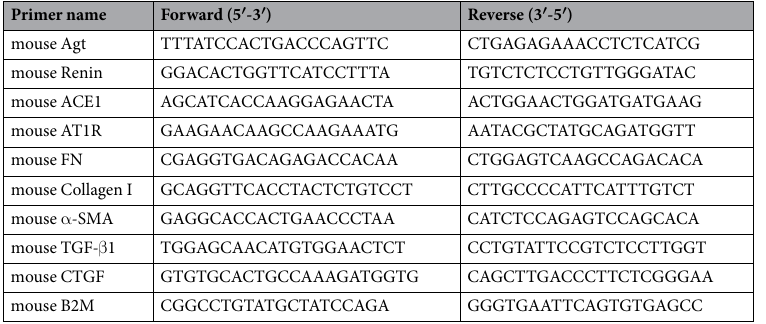
Table 2. Primer sequences used for the real-time PCR. Agt: angiotensinogen; ACE1: angiotensin converting enzyme 1; AT1R: angiotensin II type 1 receptor; FN: fibronectin; α -SMA: α -smooth muscle actin; TGF- β 1: transforming growth factor- β 1; CTGF: connective tissue growth factor; B2M: β